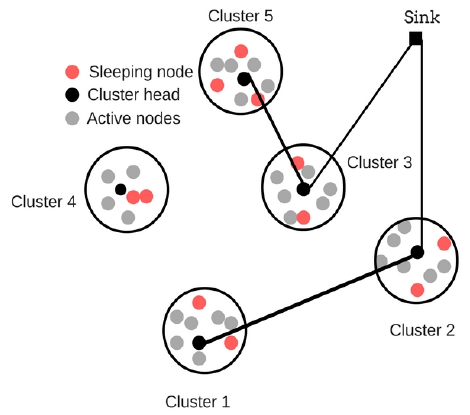
Figure 2. Cooperative transmission of data by cluster heads (CHs) in pairs.